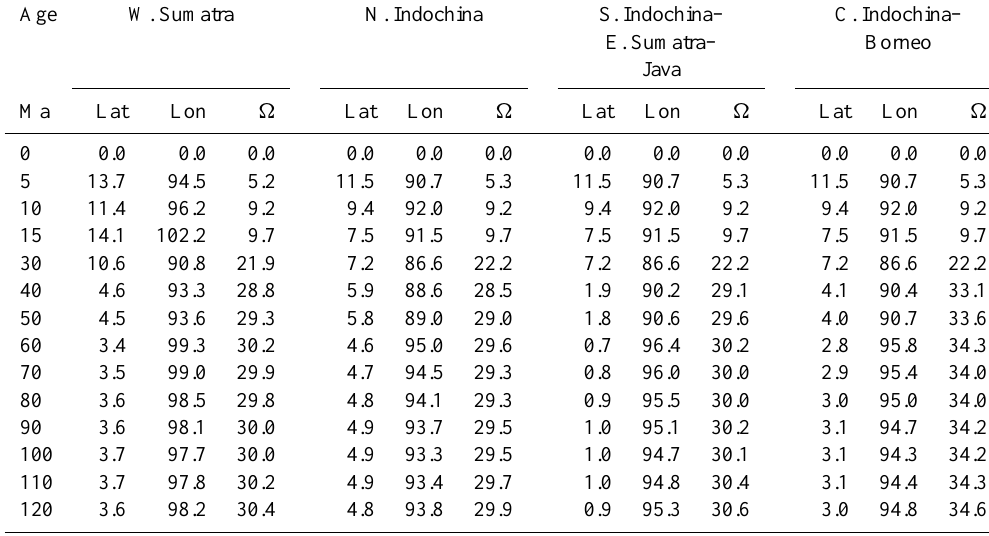
Table 2. Total rotation poles for the SE Asian blocks.